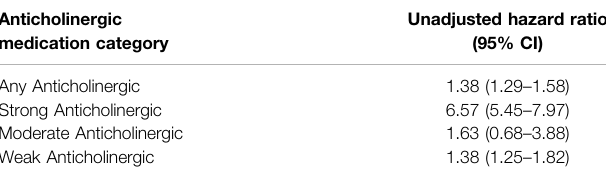
TABLE 2 | Multivariate regression fi ndings for relationships between the TABLE3| CoxregressionresultsforlikelihoodofinitiatingaPPIwithin180 daysof prescribing cascade and potential risk factors. ananticholinergicmedicationfromtheAnticholinergicCognitiveBurdenScale. Covariates Unadjusted odds ratio Adjusted odds ratio Anticholinergic (95% CI) (95%CI) medication